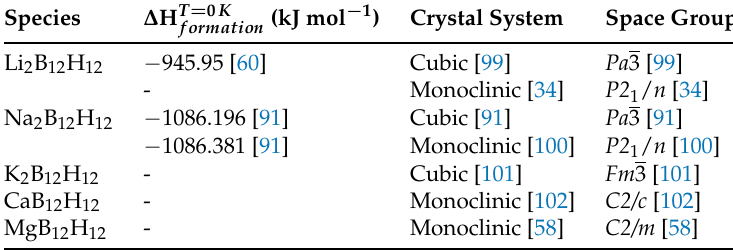
Table 4. Structural and thermodynamic data reported for the common alkali and alkaline earth dodecaborates. The theoretically predicted enthalpy of formation ( ∆ H T = 0 K are available in literature. All given structures refer to the ambient temperature